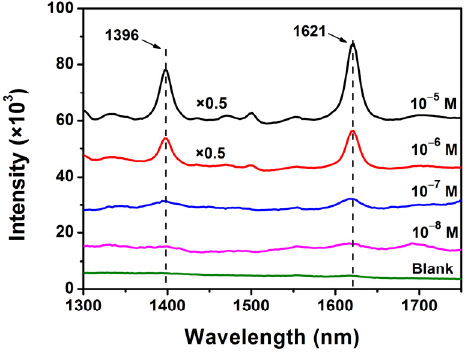
Figure 8. SERS spectra of MB with different concentrations enhanced by Ag@mTiO 2 nanoparticles.